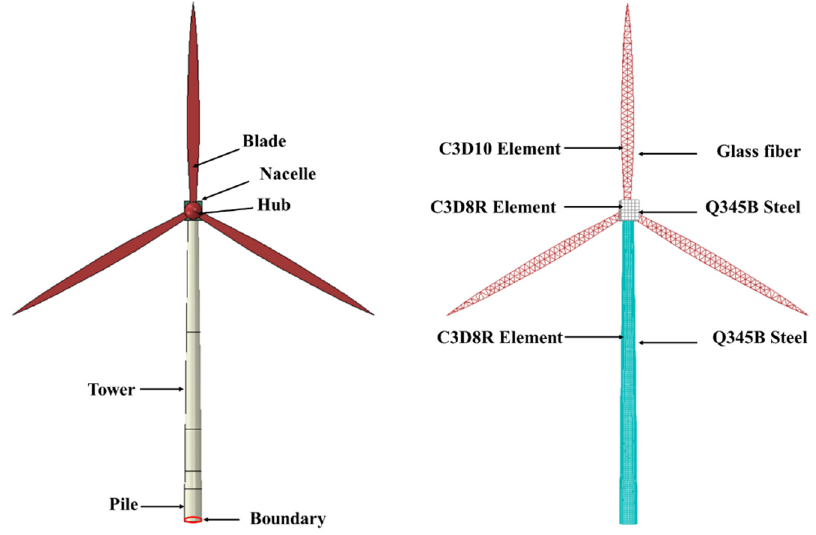
Figure 3. FE model of wind turbine tower structure.